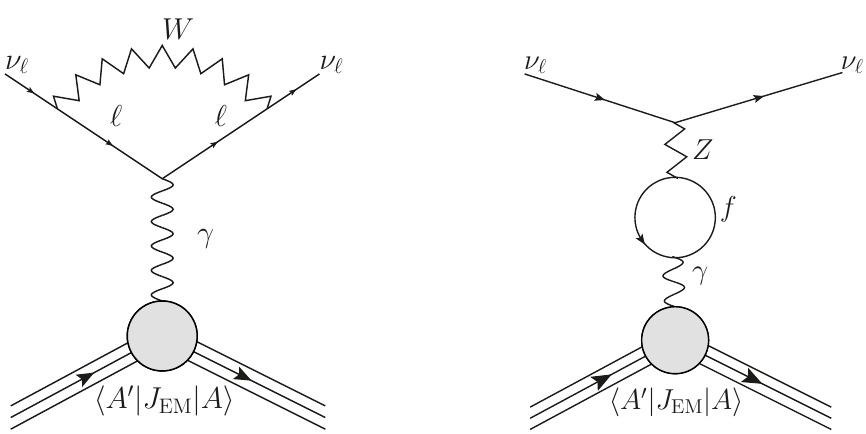
Figure 1 . Radiative corrections induce a photon-mediated interaction with nuclei. Charged cur- rents (left diagram) lead to flavor-dependent calculable corrections. Neutral currents (right dia- gram) lead to flavor-independent corrections, some of which involve light quarks and are inherently nonperturbative. Rather than working directly with the Standard Model Lagrangian, we use a more efficient four-fermion treatment [118–120] presented in section 2.1, that incorporates all